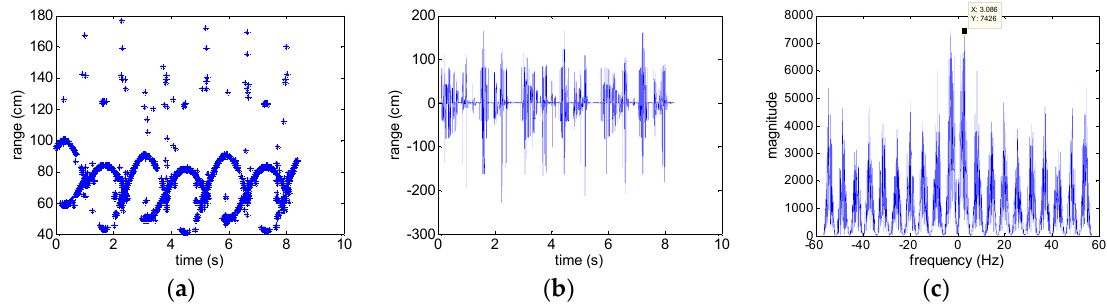
Figure 5. The HRRPs aligned by entropy minimization in different length of smooth window, they are 5, 10, and 15 slow-time sampling units respectively.